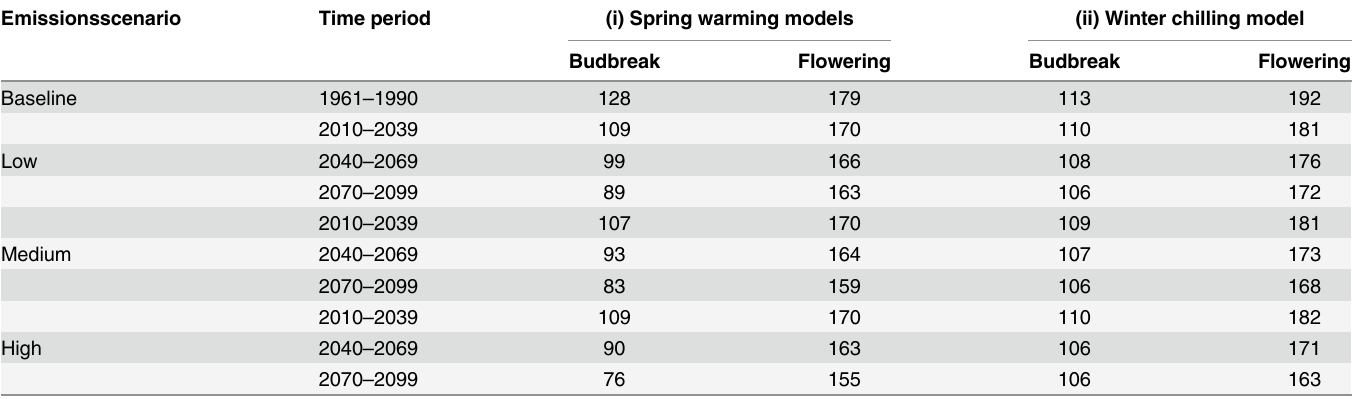
Table 4. Mean budbreak and flowering times under different climate conditions using two types of phenology model: (i) spring warming budbreak and flowering models [58, 60, 62], and (ii) winter chilling (vernalization) models [53]. Emissionsscenario Time period (i) Spring warming models (ii) Winter chilling model Budbreak Flowering Budbreak Flowering